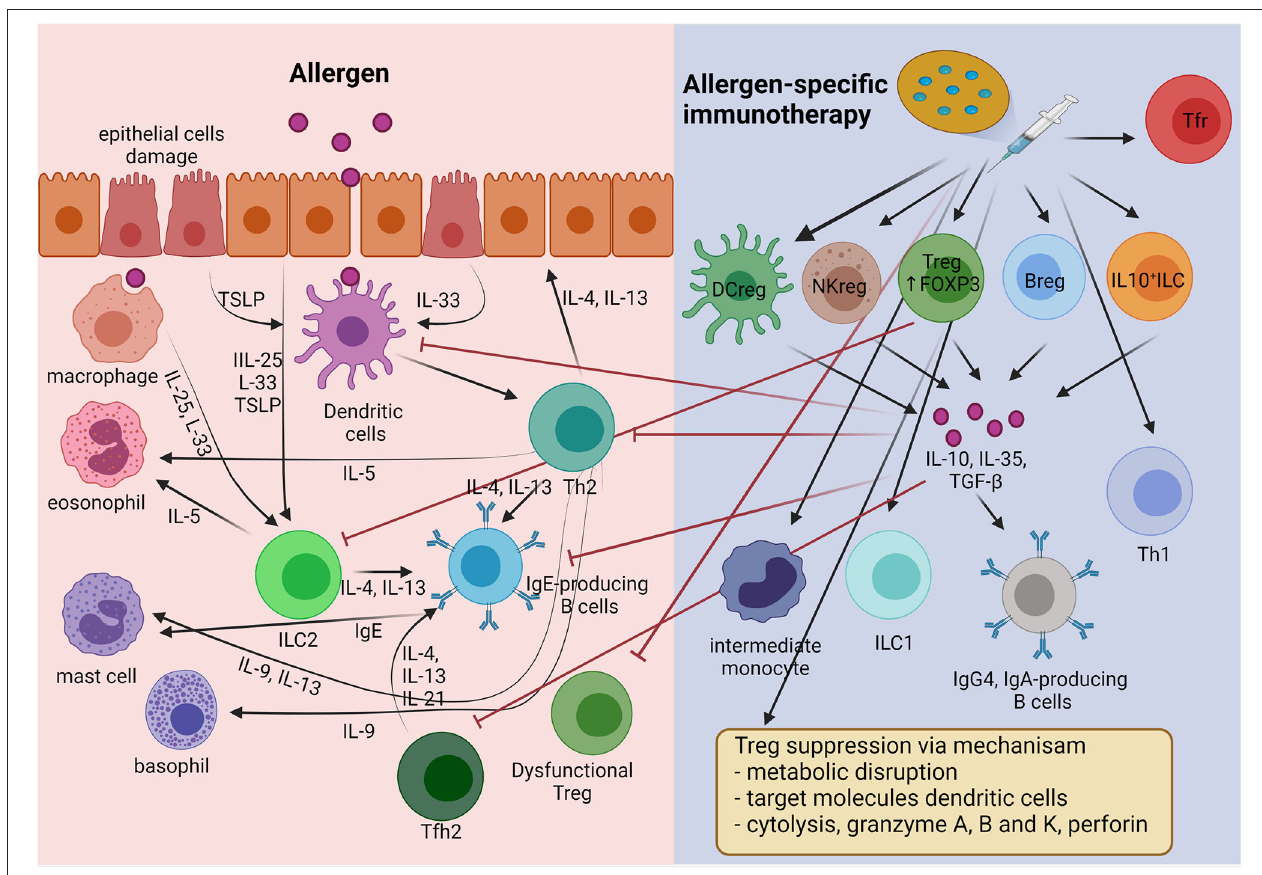
FIGURE 1 | The mechanism of immune tolerance to allergen induces by allergen-specific immunotherapy (AIT). AIT principally induces regulatory cells including Treg, Breg, Tfr, DCreg, NKreg, and IL-10 + ILC cells. Treg cells apply four main mechanisms for suppressing inflammatory cells (inhibitory cytokines, cytolysis, metabolic disruption, and targeting DCs). In addition, the regulatory cells produce IL-10 to suppress the type 2 inflammatory cells involved in allergic inflammation, such as Th2, Tfh2, IgE-producing B cells, and ILC2s. Moreover, AIT induces allergen-specific immunoglobulin class-switch, promoting IgG4 and